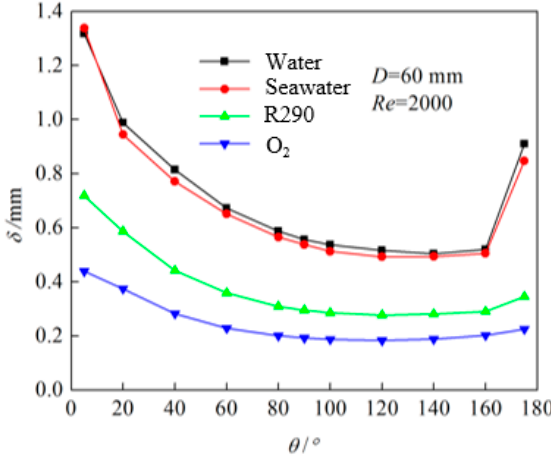
Figure 12. Local film thickness δ on the horizontal round tube.